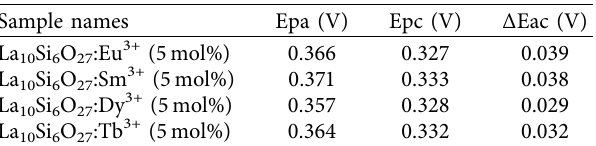
Figure 7: CV plots of La 3+ (5mol %) nanophosphors with 30mV/s scan rates. 10 Si 6 O 27 :RE Table 3: Oxidation potential (Epa), reduction potential (Epc), and the difference between Epa and Epc of La 10 Si 6 O 27 :RE 3+ (5mol%) NPs